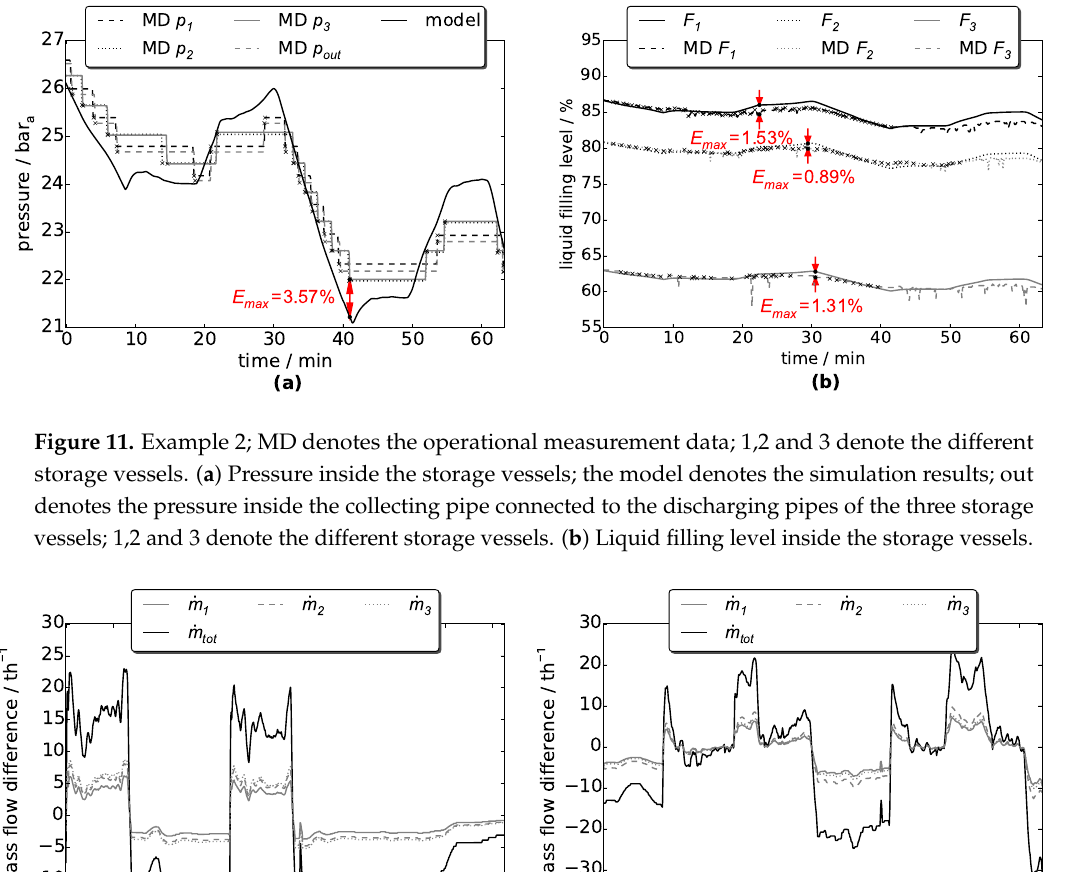
min−15−10 0 10 20 30 40 50 60 70 80 90 time /